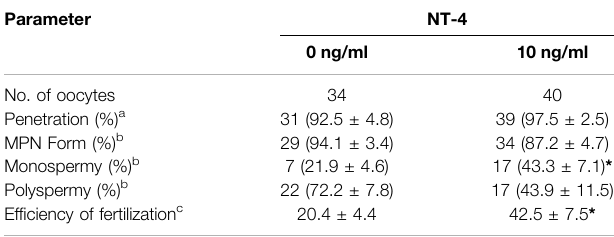
TABLE 1 | Effect of neurotrophin-4 (NT-4) on sperm penetration of porcine oocytes during in vitro maturation (IVM) at 12 h post insemination.